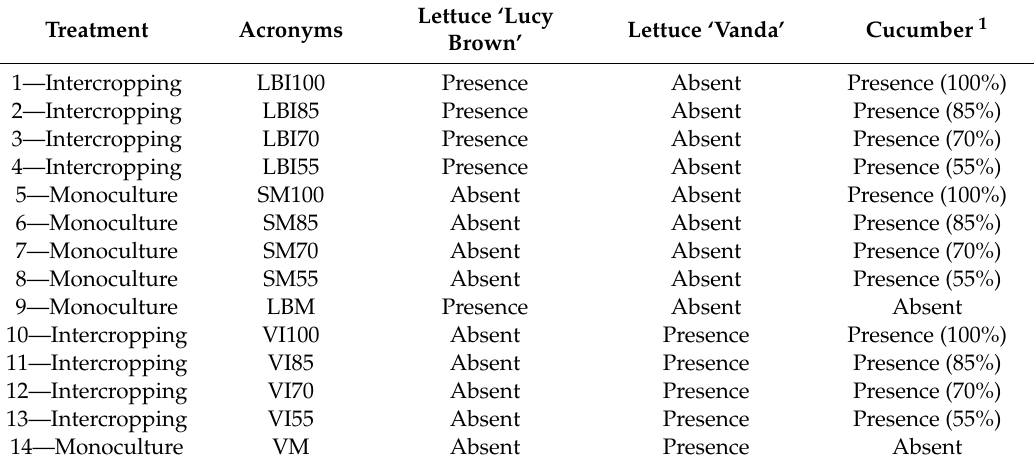
Table 1. Characterization of monoculture treatments and intercrop of two lettuce cultivars and four cucumber population